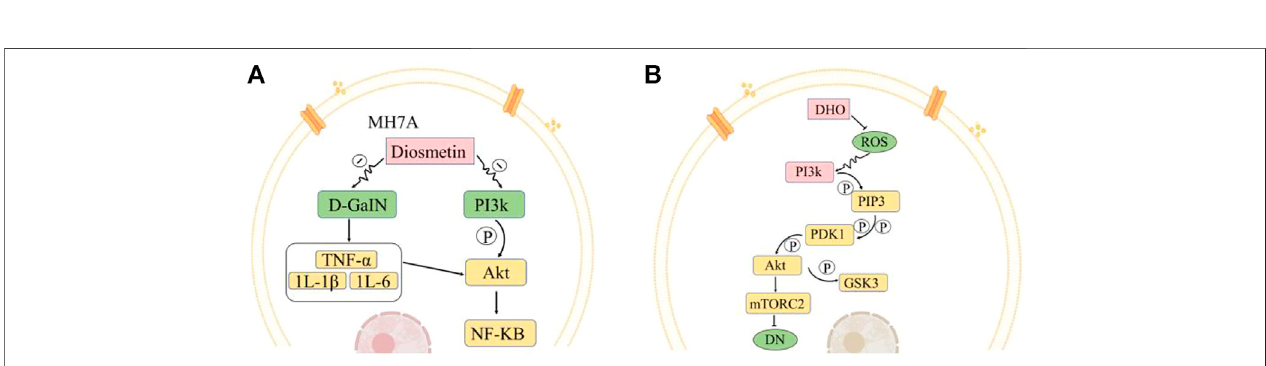
FIGURE 3 | Representative medicinal compounds in O. fragrans and their pharmacological mechanisms of action. (A) Pathways by which Dio affects MH7A cell apoptosis. Dio inhibits the production of in fl ammatory mediators and cytokines (TNF- α , IL-1 β , IL-6, etc.) induced by D-GalN and can also regulate the Akt/NF-kB pathway. Dio can also inhibit the PI3K/Akt pathway. PI3k is phosphorylated to generate Akt, and Akt is a key molecule in the activation of the NF- κ B signalling pathway. Inhibition of this pathway reduces cell proliferation and in fl ammatory cytokine production in MH7A cells and promotes apoptosis. (B) Effects of DHQ on the mTORC2/Akt signalling pathway under high-glucose conditions. Reactive oxygen species (ROS) can activate the protein kinase PI3K signalling pathway. There are two downstream pathways of PI3k. In the one presented here, the PI3k-Akt signalling pathway affects mTORC2 and mTORC1. PI3k generates PIP3, PIP3 further activates PDK1, PDK1 activatesAkt through phosphorylation,and Aktfurtheractivates mTORC2. DHQhasan inhibitory effect onROSproduction.Aftertheaddition ofDHQ, the activity of ROS is reduced, the regulatory effect of ROS on the PI3k pathway is weakened, the expression of Akt, which is downstream of PI3k, is decreased, and the expression of mTORC2, which is downstream of Akt, is inhibited. Akt phosphorylation can regulate GSK3 and reduce cell survival to ameliorate diabetic nephropathy in rats. (Red indicates increase/promotion, green indicates decrease/inhibition, and yellow indicates promotion of the original pathway but inhibition of this pathway.)